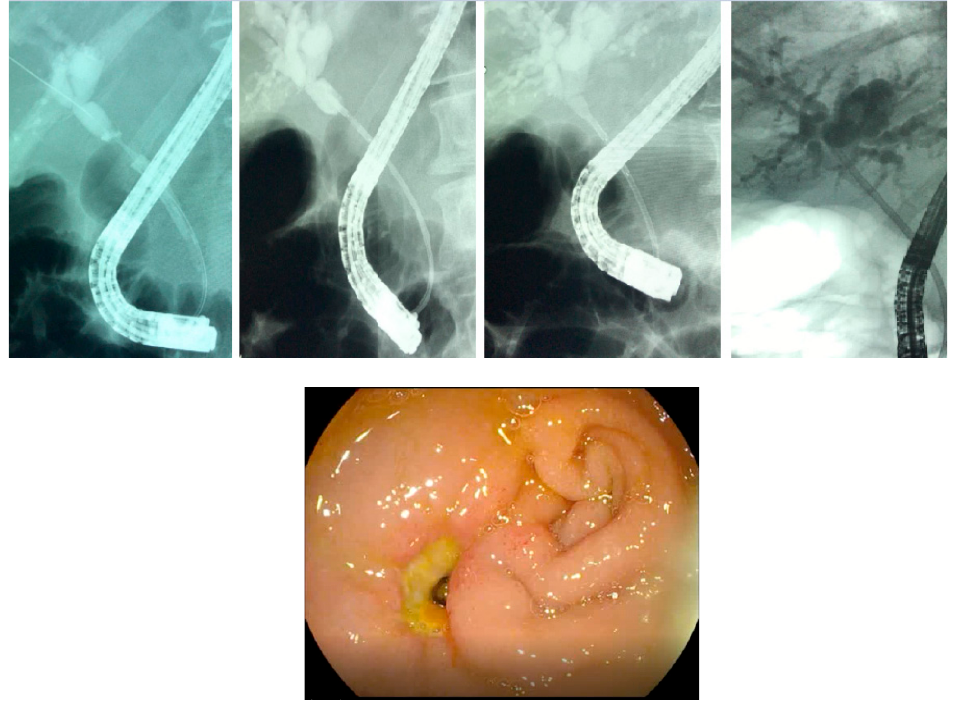
Figure 4. Choledochoduodenal fistula after RFA for cholangiocarcinoma due to proximity of the duodenum.